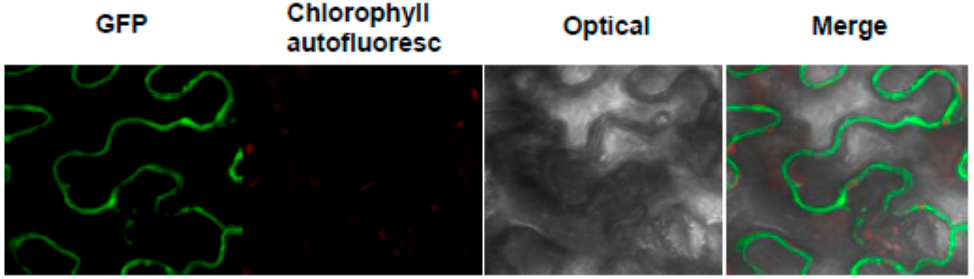
Figure 5. Expression of the p 35S::MeHFT-GFP transgene in a transiently transformed N. benthamiana leaf reveals the localization of MeHFT to the cytoplasm. The GFP signal appears green and the chlorophyll auto-fluorescence signal red.